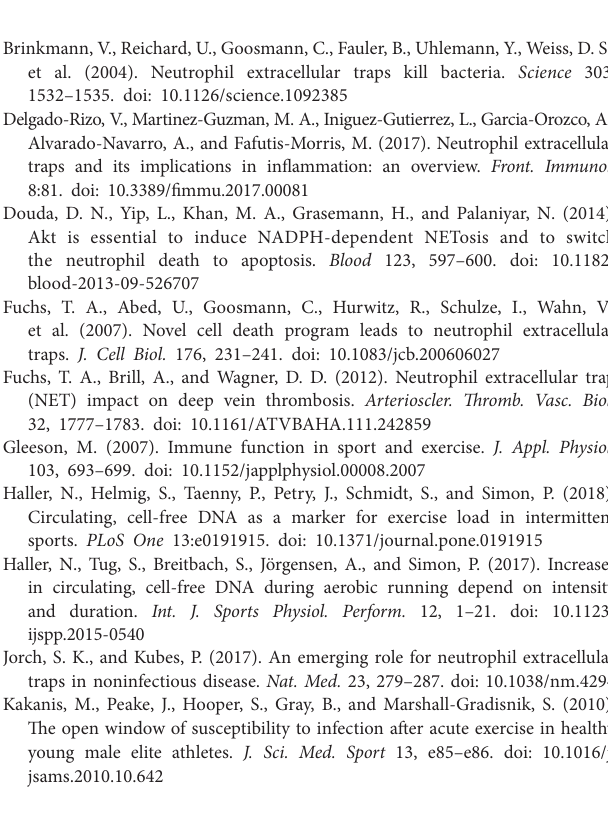
SUPPLEMENTARY FIGURE S1 | Percentages of Dead/Live cells and the purity of isolated neutrophils from mice bone marrow. PI-PE was used to distinguish the dead from live cells, the flow cytometry shows the live and dead cells account for 90 and 6.77%, respectively. CD11b-FITC and Ly6G-PE-cy7 fluorescent dye were used to mark the surface marker of neutrophils; the result shows the neutrophils of CD11b+Ly6G+ accounts for more than